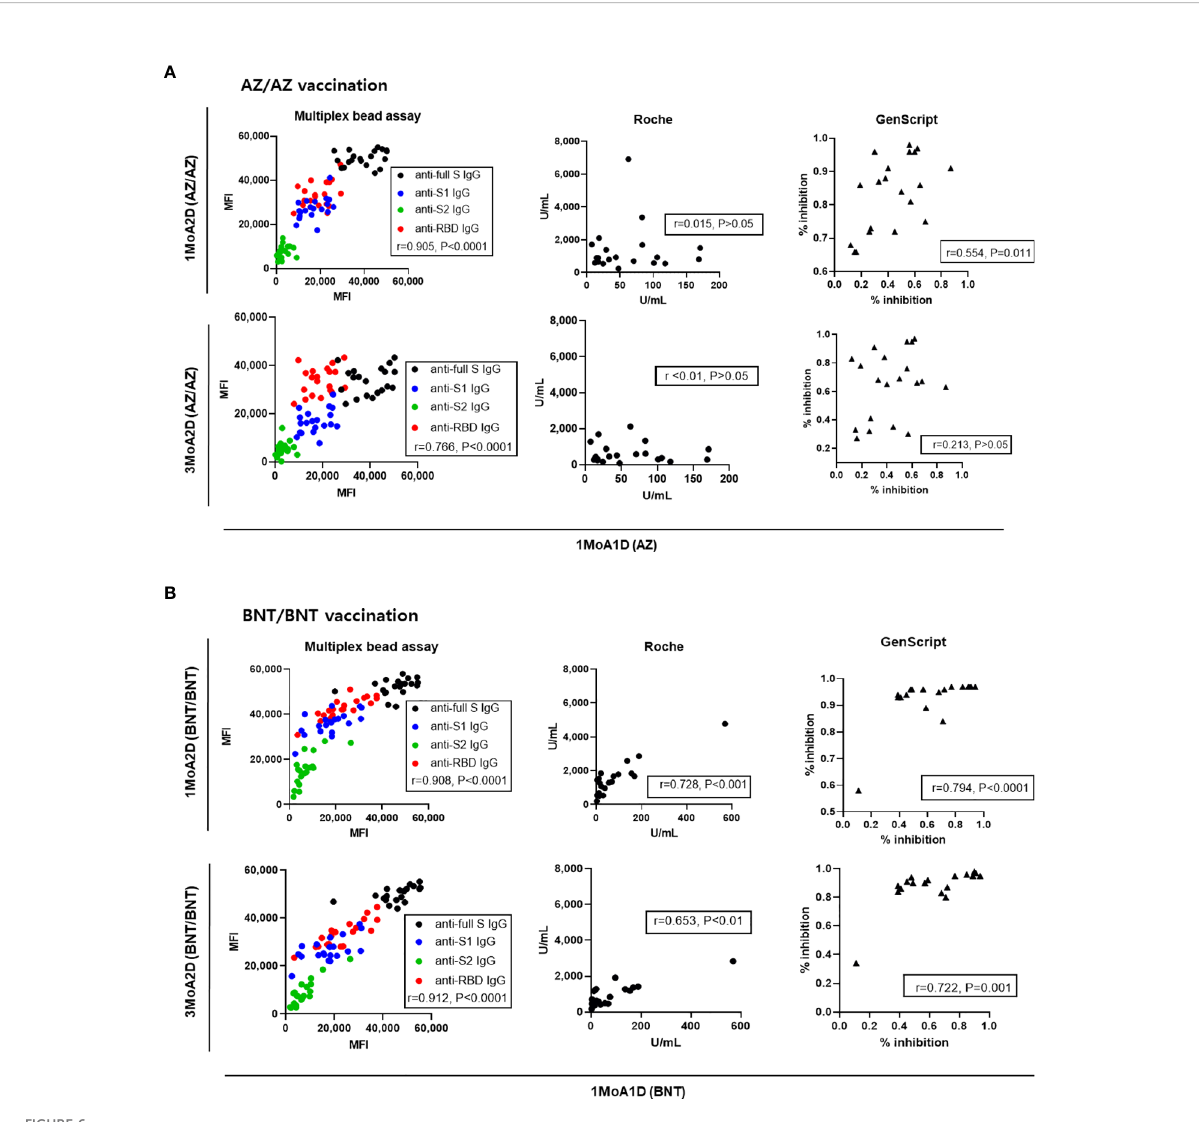
FIGURE 6 Correlation of antibody levels between post-prime and post-boost vaccination in 20 AZ/AZ (A) and 20 BNT/BNT (B) vaccinated health care